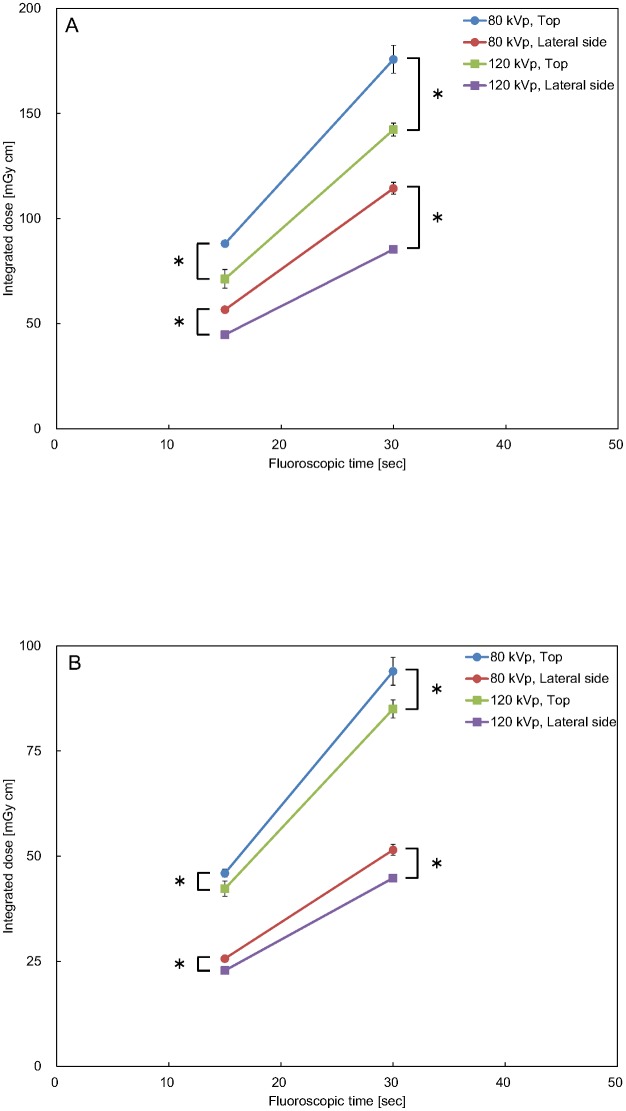
Integrated doses for the different measurement positions and tube voltage.There were statistically significant differences (* p < 0.0001) as determined by two-way ANOVA between the main effects (measurement positions and tube voltage) for each fluoroscopic time. Error bars depict standard error of triplicates. A: Primary X-ray beam. B: Scatter radiation.